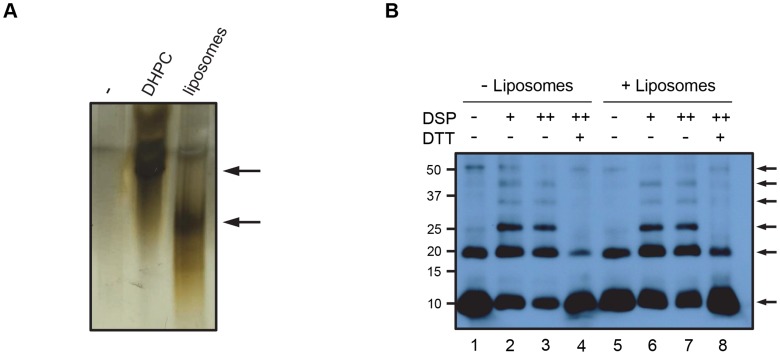
VP4 forms a multimeric complex.
A. VP4His was incubated in the presence of the membrane-mimetic detergent DHPC or liposomes, or mock-treated (−), resolved by native PAGE and visualised by silver staining. The position of bands shown by arrows indicates potential migration of VP4His into the gel. B. VP4 was incubated with (+) or without (−) liposomes and crosslinked by the addition of DSP at 0.5 mM (+) or 1 mM (++). Samples were resolved by non-reducing SDS-PAGE and detected by western blot using antisera to VP4. DTT was used in some samples to reverse the crosslinking prior to SDS-PAGE. Arrows indicate VP4 multimers. Molecular mass markers (in kilodaltons) are indicated on the left.